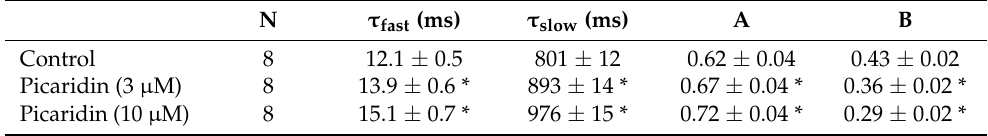
Table 1. Summary of results showing the parameter values for effects of picaridin on the recovery of the I Na block during the preceding train pulse. These parameters are elaborated in detail in Materials and Methods. All values are mean ± SEM. * Significantly different from controls ( p <